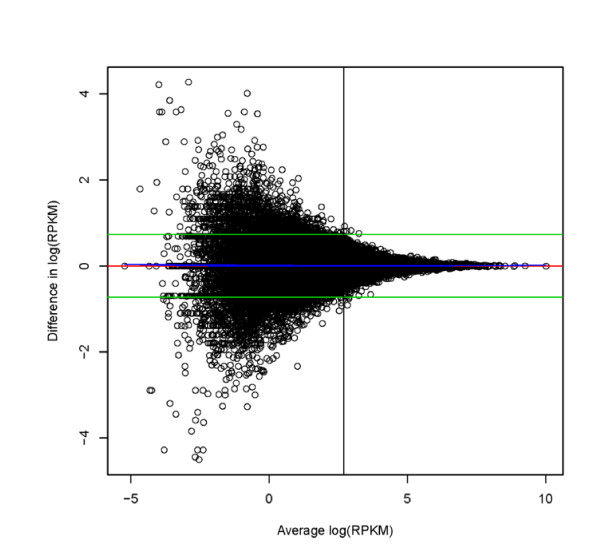
Bland-Altman plot showing level of agreement between technical replicates for natural log transformed RPKM D. simulans biological replicate 3. On the Y axis is the difference between technical replicates and on the X axis is the average between technical replicates. Green lines are the average of all differences +/- 1.96 (standard deviation of the differences). The red line is drawn at zero. The blue line is a loess fit. The discrepancy between technical replicates is a function of the estimated expression level. The horizontal line is drawn at an average coverage per nucleotide of 5. Bland-Altman plots for all the remaining comparisons among technical replicates are in Additional file 11.